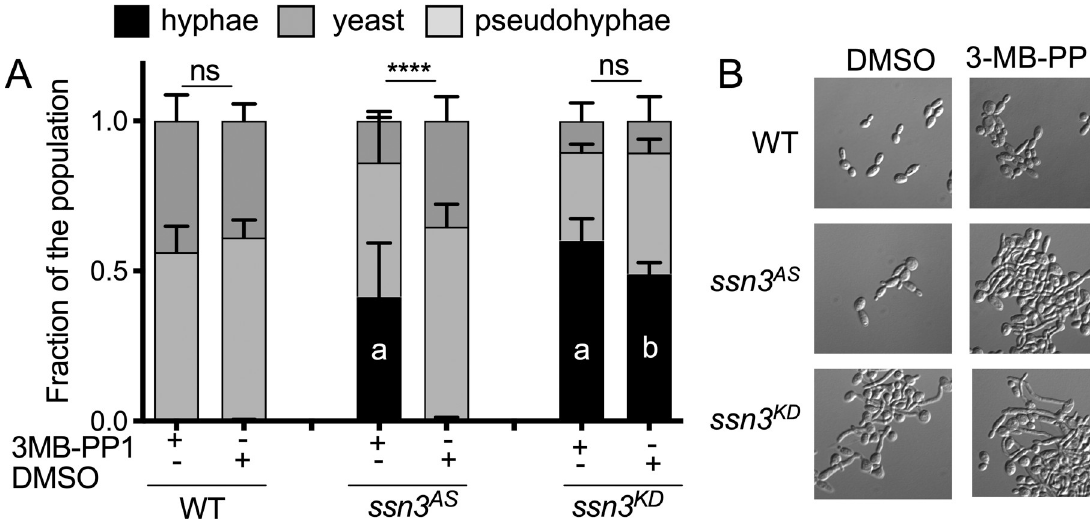
Fig 2. 3-MB-PP1 stimulates hyphal growth in a strain bearing analog-sensitive alleles of SSN3 . A. Morphology of SC5314 (WT), ssn3 AS and ssn3 KD strains was assessed after growth in YNBAG supplemented with either 5 μ M 3-MB-PP1 or vehicle (DMSO) for 3h at 30˚C. Quantification of yeast, pseudohyphae and hyphae in cultures was performed by microscopic analysis of blinded samples. Results from ANOVA with multiple comparisons for the percent of cells as hyphae is shown; ���� , p < 0.001, ns, not significant. Lower case letters indicate statistically significant differences in comparison to a) WT with 3MB-PP1 at p < 0.001 or b) to WT with DMSO at p < 0.001. B. Representative images of cell populations from cultures analyzed in panel A are